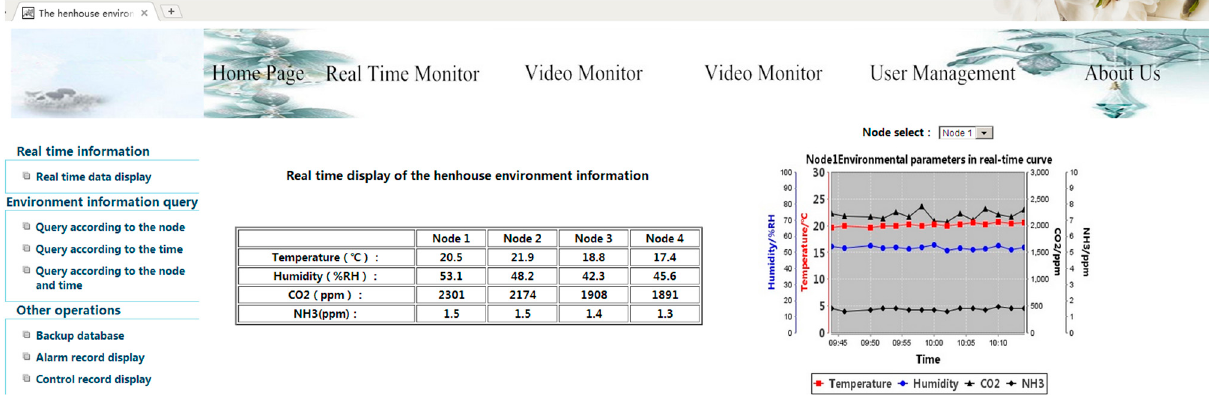
Figure 5. Operation interface of the field monitoring subsystem.